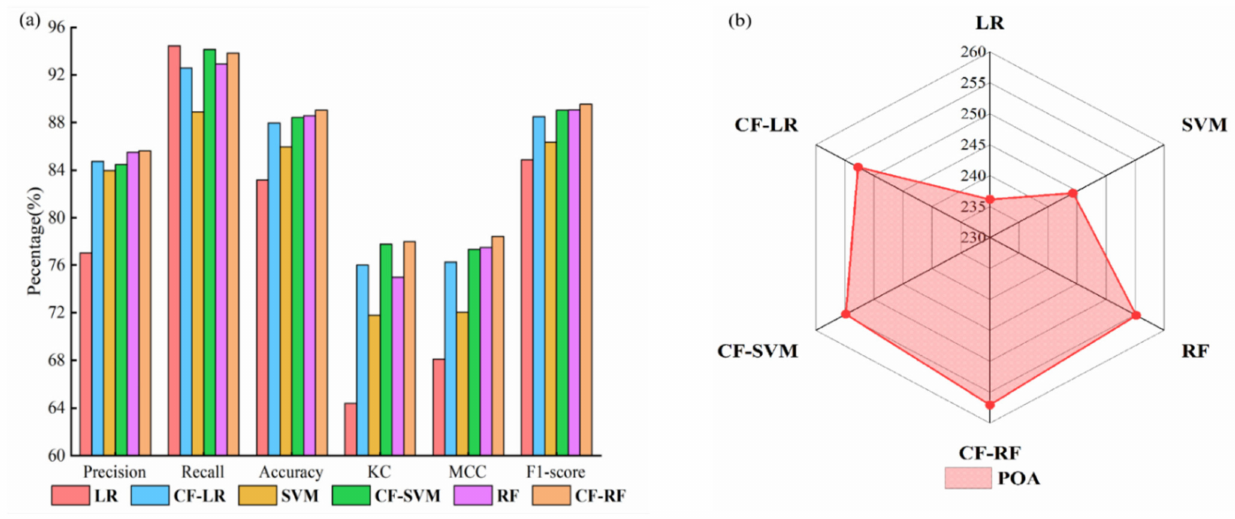
Figure 7. Precision comparison of the models ( a ) precision, recall, accuracy, KC, MCC, and F1-score; ( b ) POA of the